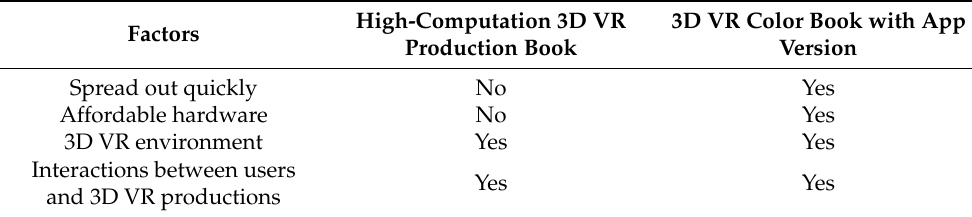
Table 1. A comparison for a color book as course material implemented by two